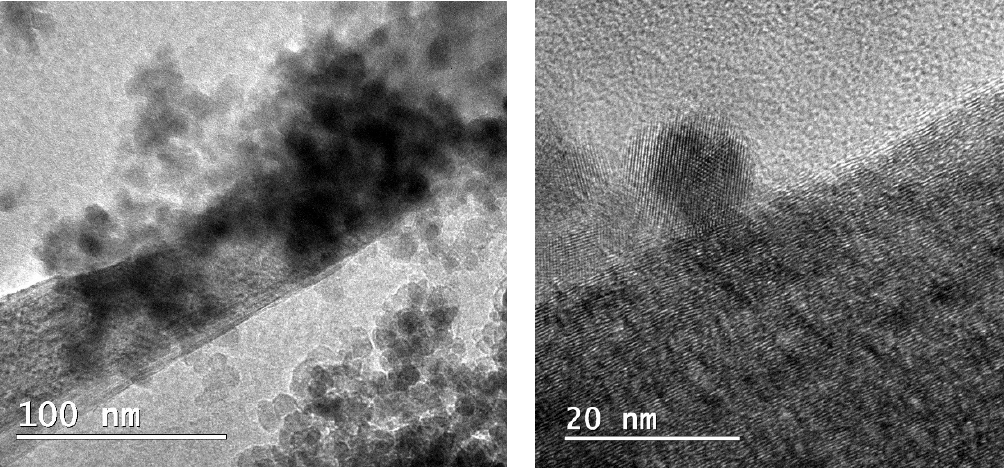
Figure 4. TEM micrographs of the obtained nanocomposites.